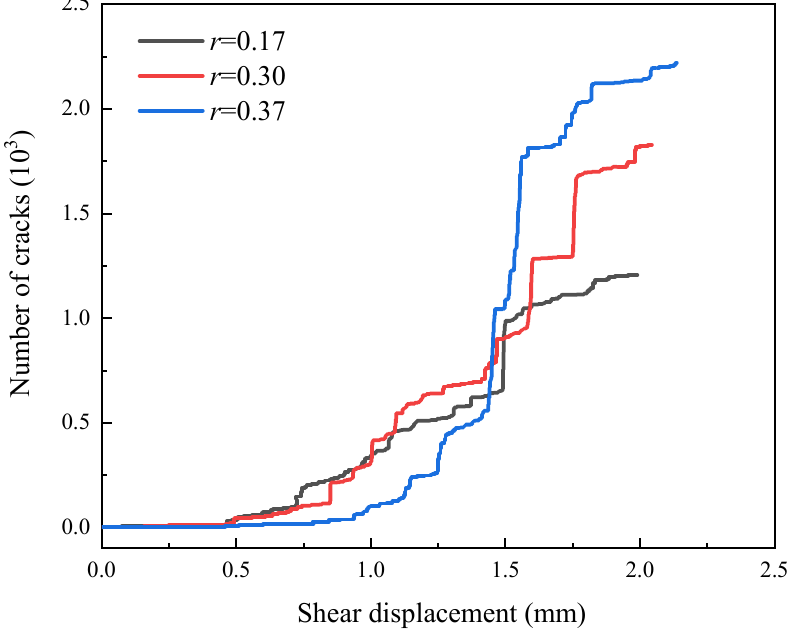
Figure 6. Cumulative cracks with increasing shear displacement of joints with different roughness sheared.